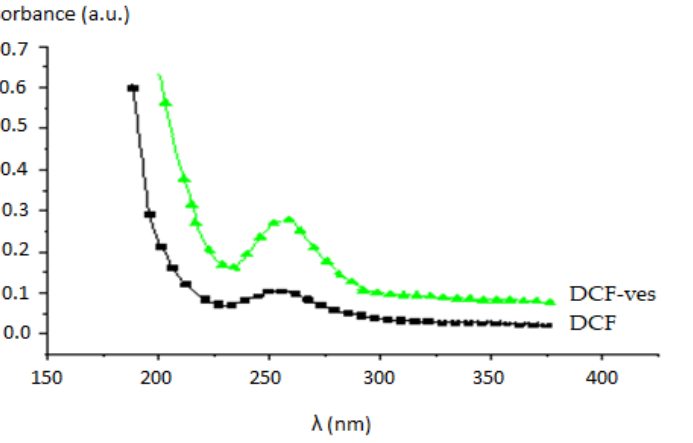
Figure 7. The absorption spectra of DCF and DCF-ves (legend: a.u. – absorption units, λ– wavelength).